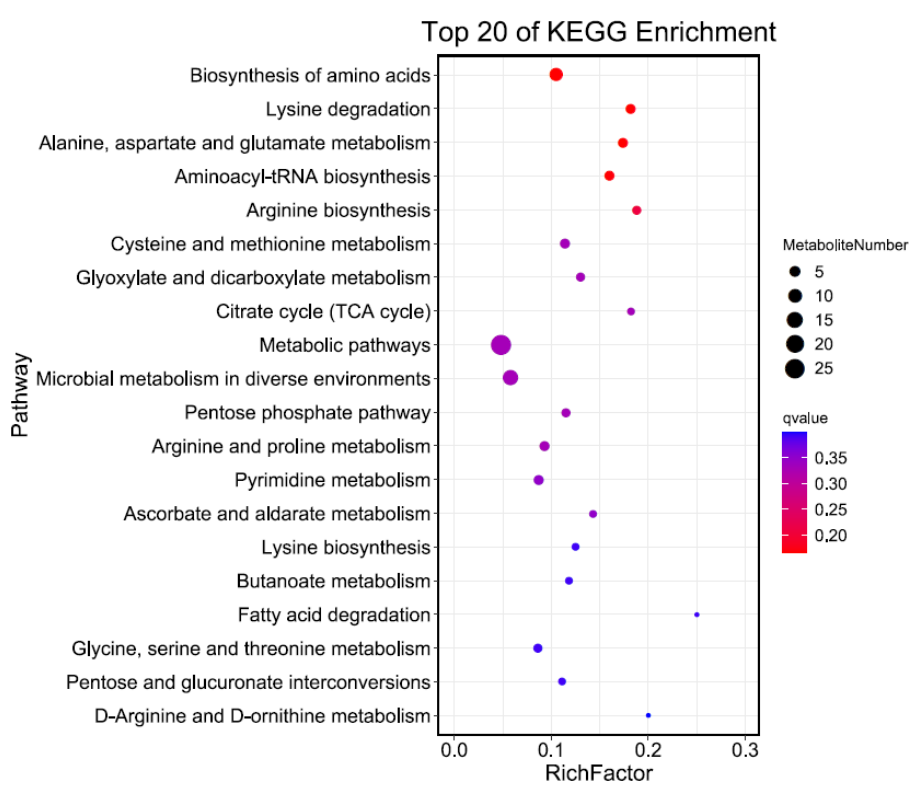
Figure 5. Kyoto Encyclopedia of Genes and Genomes pathway enrichment analysis of differentially accumulated metabolites in “G32” and “J120” . accumulated metabolites in “G32” and